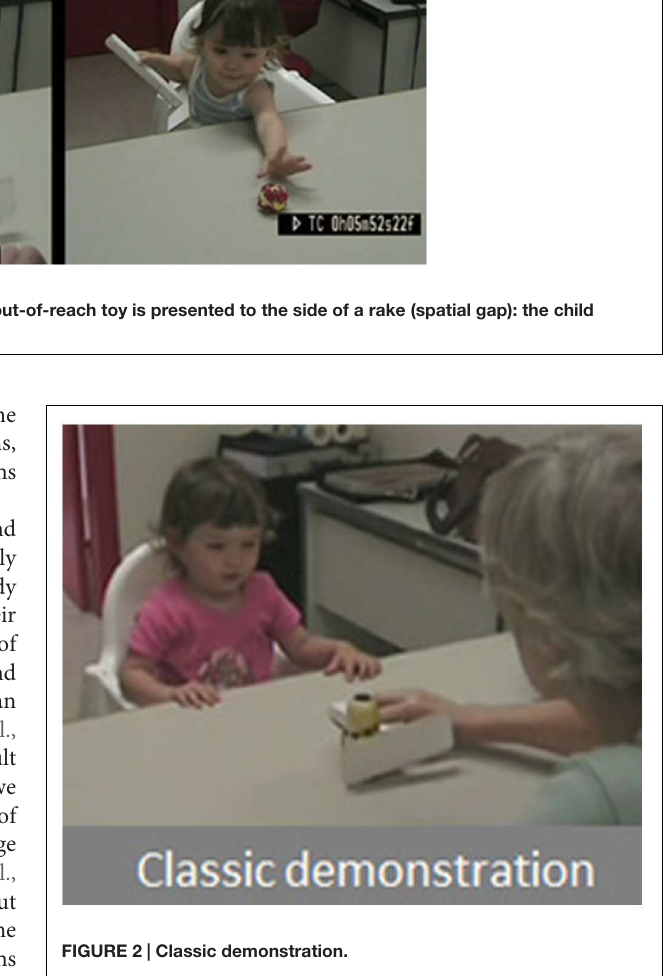
FIGURE 2 | Classic